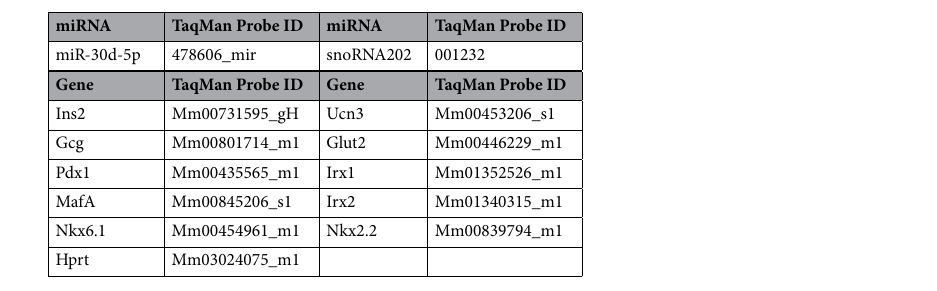
Table 2. List of TaqMan assay probes for analyzing miRNA and gene expression by